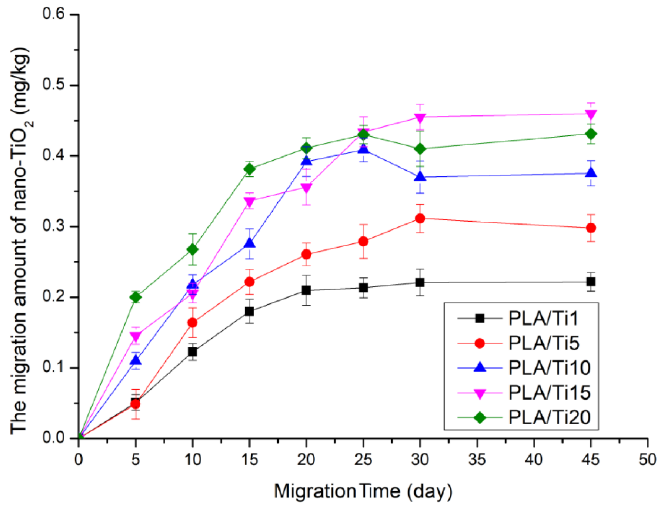
Figure 7. The concentration of TiO 2 NPs migrated from PLA-TiO 2 nanocomposite film to 50% ( v / v ) ethanol solution as food simulant after high-pressure treatment of 300 MPa for 10 min in a migration period of 0 to 45 days, Reprinted from Ref. [60].